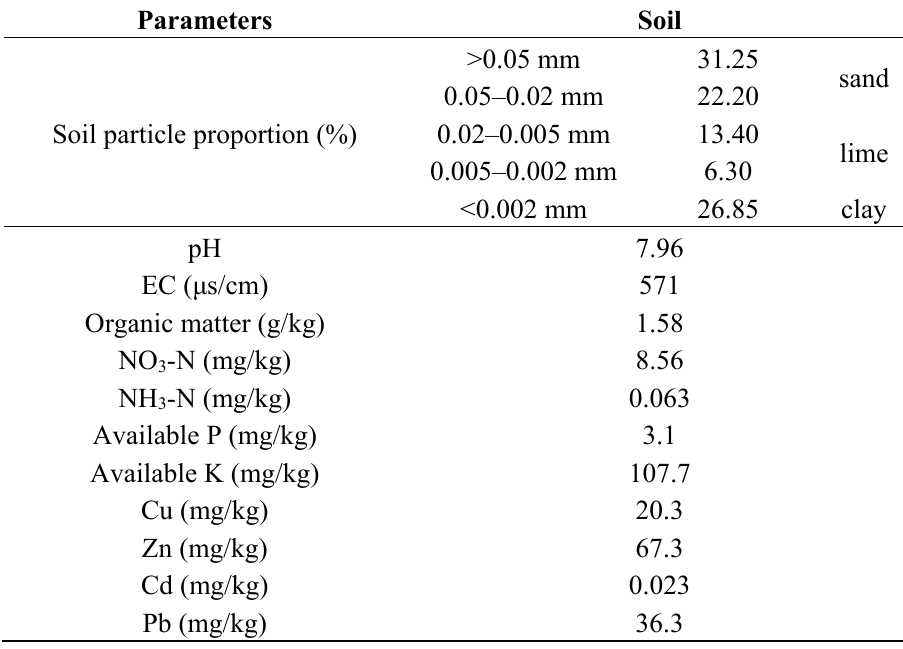
Table 1. Physicochemical properties of the experimental soil